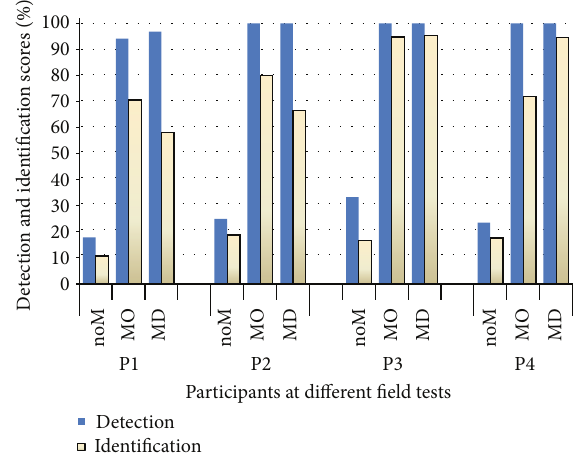
Figure 4: Detection and identification scores of events occurring in the home environment for four participants with Usher’s Syndrome type I, when they were tested without Monitor (noM), with Monitor with omnidirectional microphone (MO), and with Monitor with directional microphone